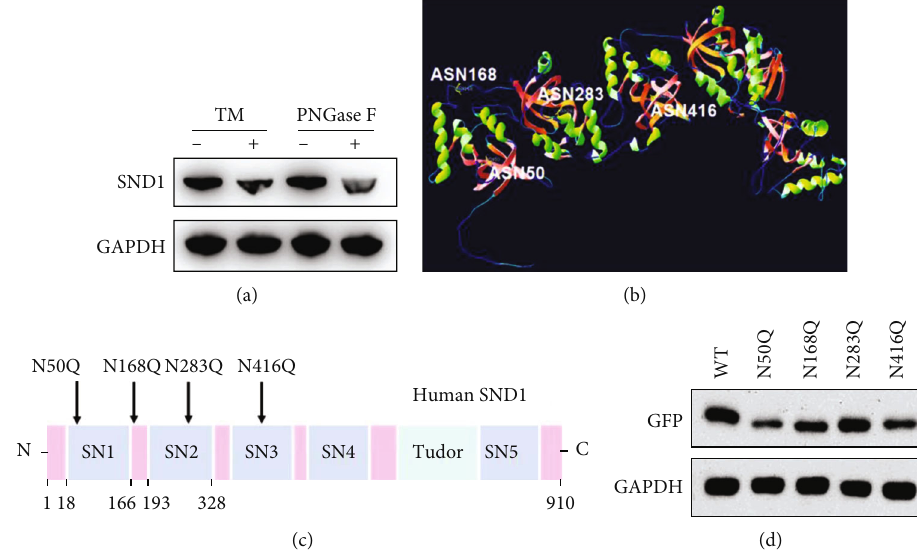
Figure 2: Analysis of N-glycosylation in SND1. (a) Human glioma U87 cells were treated by tunicamycin (TM) and peptide -N-glycosidase F (PNGase F); the level of SND1 was determined by electrophoresis in 6% SDS-PAGE and then immunoblotted with anti-SND1 antibodies. (b) Three-dimensional structure for human SND1. Locations of four potential N-glycosylation sites (Asn50, Asn168, Asn283, and Asn416) were indicated in yellow. (c) The schematic illustrates structural domains of human SND1 and its potential N-glycosylation site mutagenesis (N50Q, N168Q, N283Q, and N416Q) SN: staphylococcal nuclease domains. Asn (N); Gln (Q). (d) Cell lysate from U87 cells expressing WT- SND1, or its single mutants were analyzed by 6% SDS-PAGE with an anti-GFP antibody. GAPDH was used as a loading